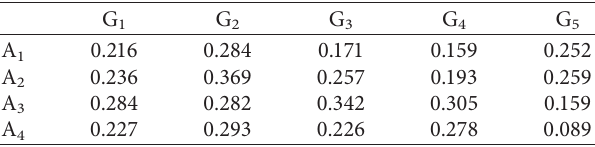
Table 6: Initial differences for each attribute in [26].